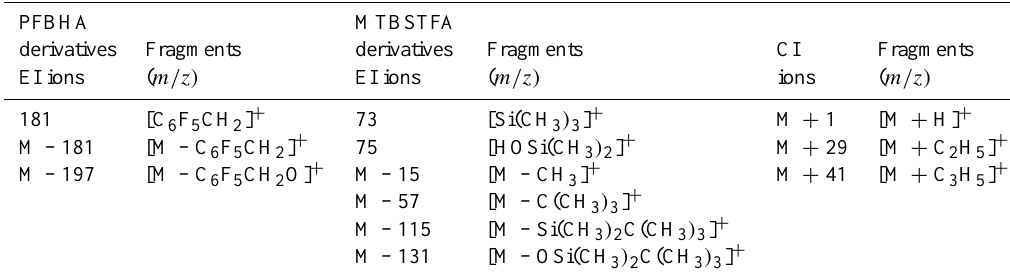
Table 6. Characteristic fragmentation of PFBHA and MTBSTFA derivatives in EI and CI